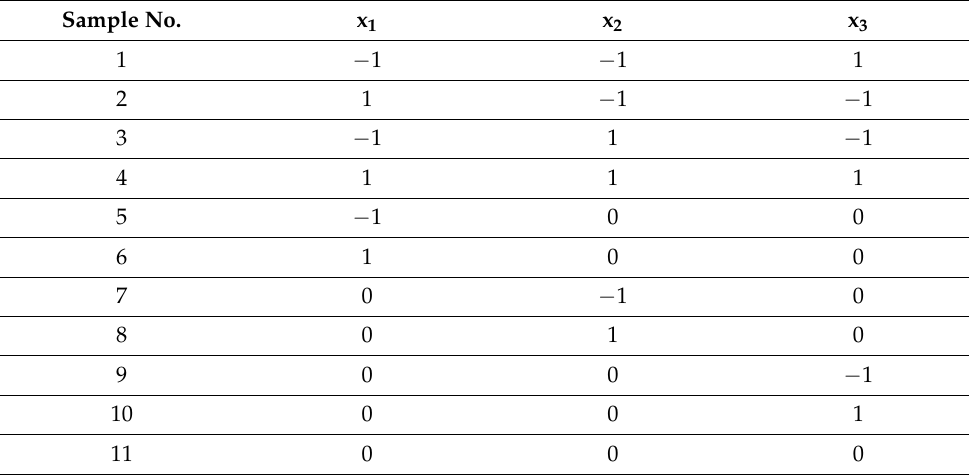
Table 1. Applied plan of the experiment. Sample No. x 1 x 2